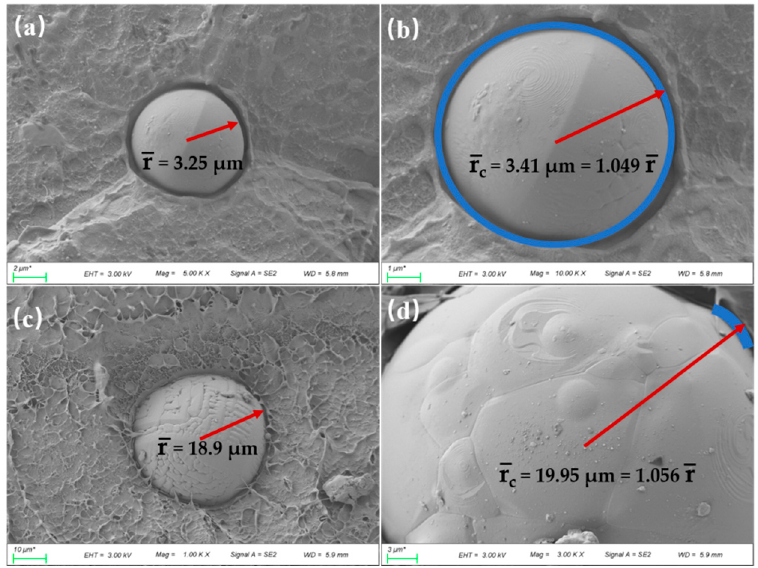
Figure 1. SEM images of LLDPE/Al 2 O 3 composites with different Al 2 O 3 diameter: ( a , b ) for Al 2 O 3 diameter with 5 μ m; ( c , d ) for Al 2 O 3 diameter with 40 μ m.